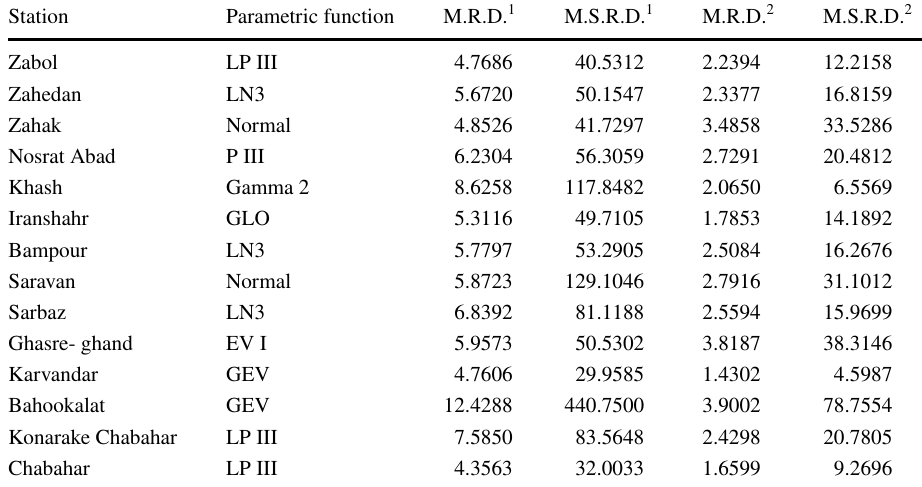
Table 3 Values of the M.R.D and M.S.R.D test statistics for the parametric distribution functions and Fourier series method